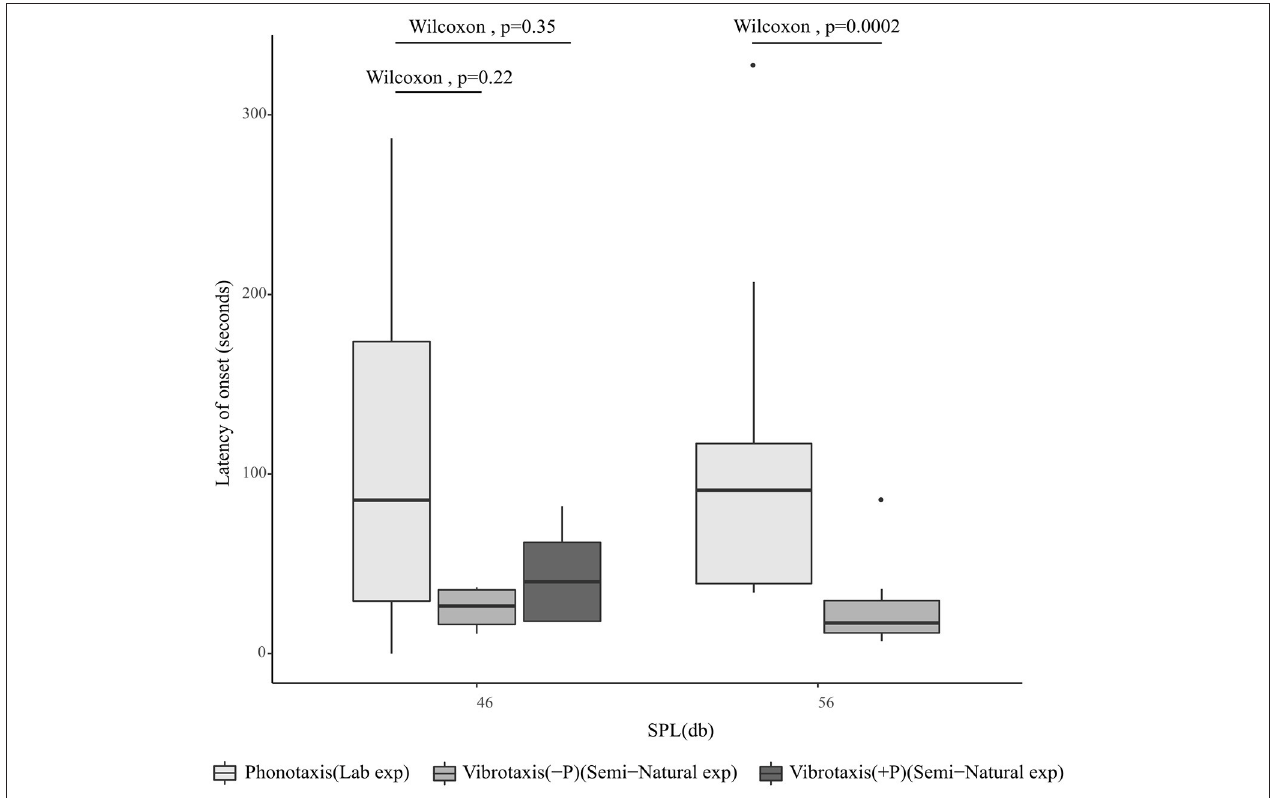
FIGURE 5 | Median latency of onset of female phonotaxis assessed in the laboratory experiment at 46 and 56 dB SPL where the position of the sound emitting speaker does not move ( n = 13), compared to time taken for the onset of male vibrotaxis as assessed in the semi-natural experiment at 4m (54 dB SPL) ( n = 11) and 9m (47) dB SPL ( n = 10). For 4m, the source of the vibrational signal was always stationary; for 9m, vibrotaxis data are segregated by whether the female did ( + P) ( n = 4) or did not perform phonotaxis (–P) ( n = 6). All vibrotaxis latencies for this plot are calculated from the onset of female tremulation, while phonotaxis latencies are calculated from the onset of the male acoustic